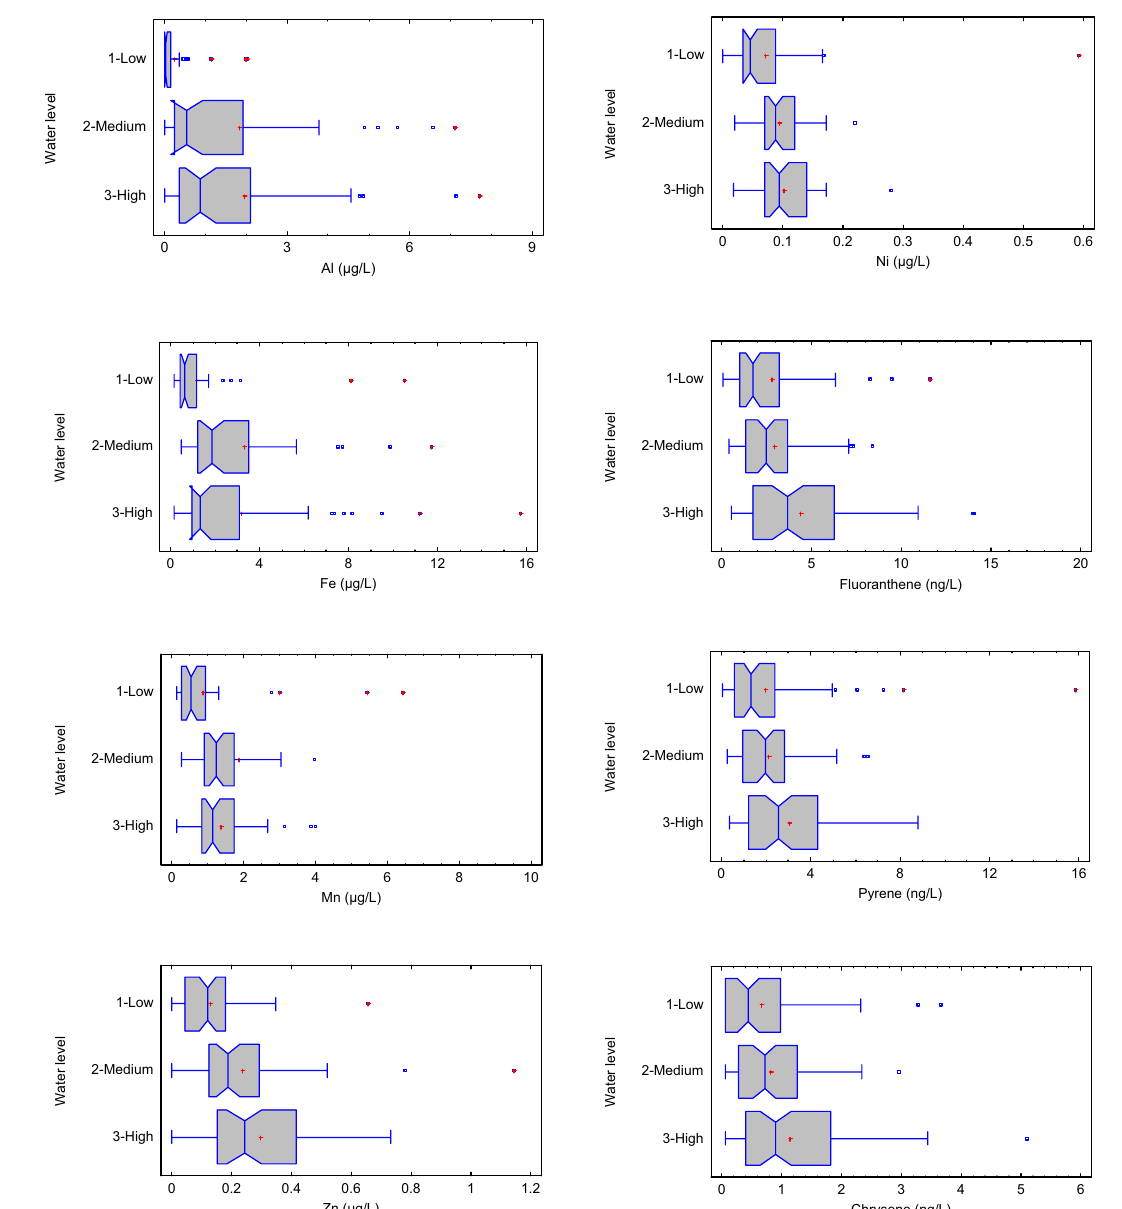
box notch corresponds to the error associated with the median. The number of samples for each water levels are respectively 50, 44 and 49 for metals and 67, 61, 68 for PAHs at low, medium and high water